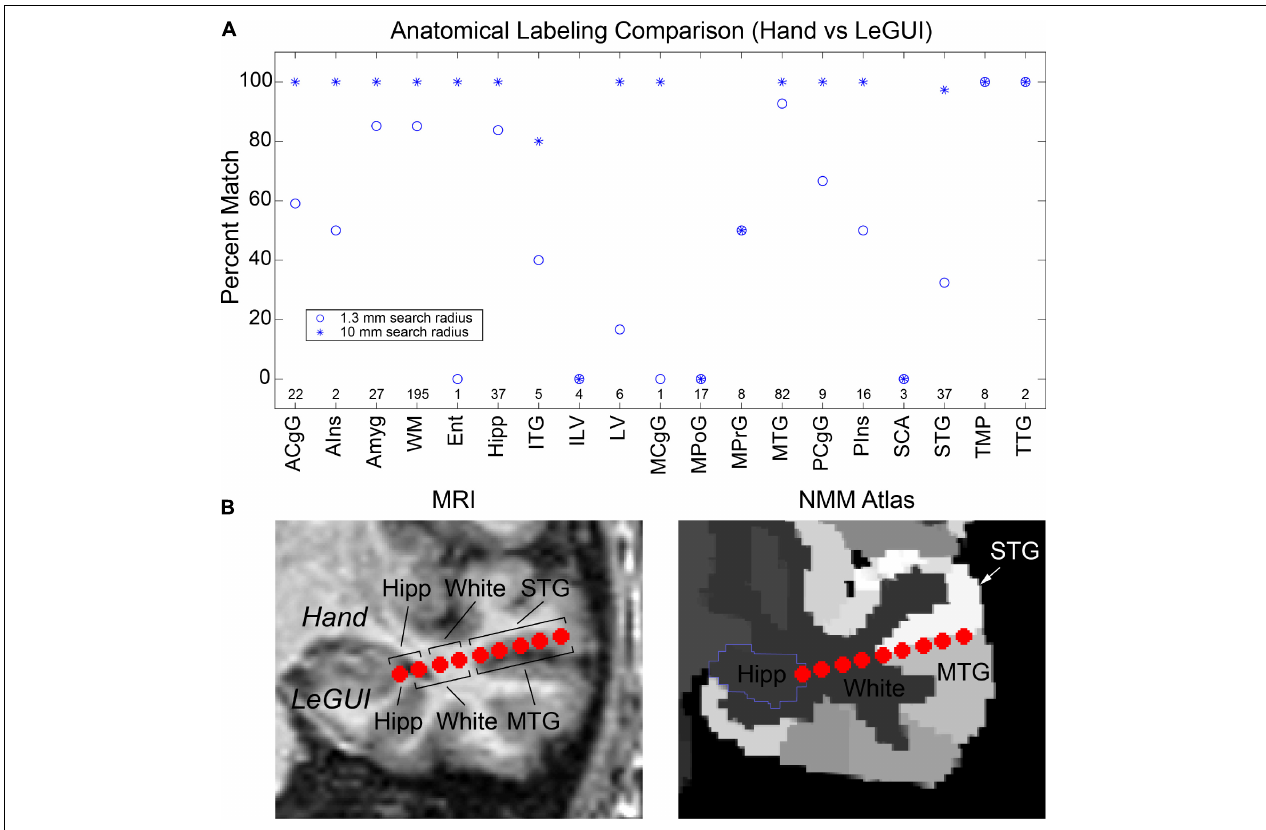
FIGURE 7 | Anatomical electrode labels generated by LeGUI closely match electrodes labeled by hand by an experienced neuroanatomist (K.W.). (A) Percent match of LeGUI labels with hand labels grouped by NMM label type. Left and right hemisphere labeling was removed for clarity. Circles indicate percent match for LeGUI labels generated using a 1.3-mm radius sphere around each electrode. Asterisks indicate percent match for labels generated using a 1-cm sphere (see Materials and Methods). Numbers above each label indicate count. (B) Example of SEEG electrode labels for a lead placed into the left temporal lobe. Electrodes are shown relative to the MRI (LeGUI inline projection feature) with the hand labels indicated above and LeGUI labels below (left). Electrodes are also shown relative to the NMM atlas (right). A mismatch can be seen between the hand (STG) and LeGUI (MTG) labels for the 5 lateral contacts. These electrodes closely follow the border between STG and MTG in the NMM atlas (right). ACgG, anterior cingulate gyrus; AIns, anterior insula; Amyg, amygdala; WM, white matter; Ent, entorhinal area; Hipp, hippocampus; ITG, inferior temporal gyrus; ILV, inferior lateral ventricle; LV, lateral ventricle; MCgG, middle cingulate gyrus; MPoG, medial postcentral gyrus; MPrG, medial precentral gyrus; MTG, middle temporal gyrus; PCgG posterior cingulate gyrus; PIns, posterior insula; SCA, subcallosal area; STG, superior temporal gyrus; TMP, temporal pole; TTG, transverse temporal